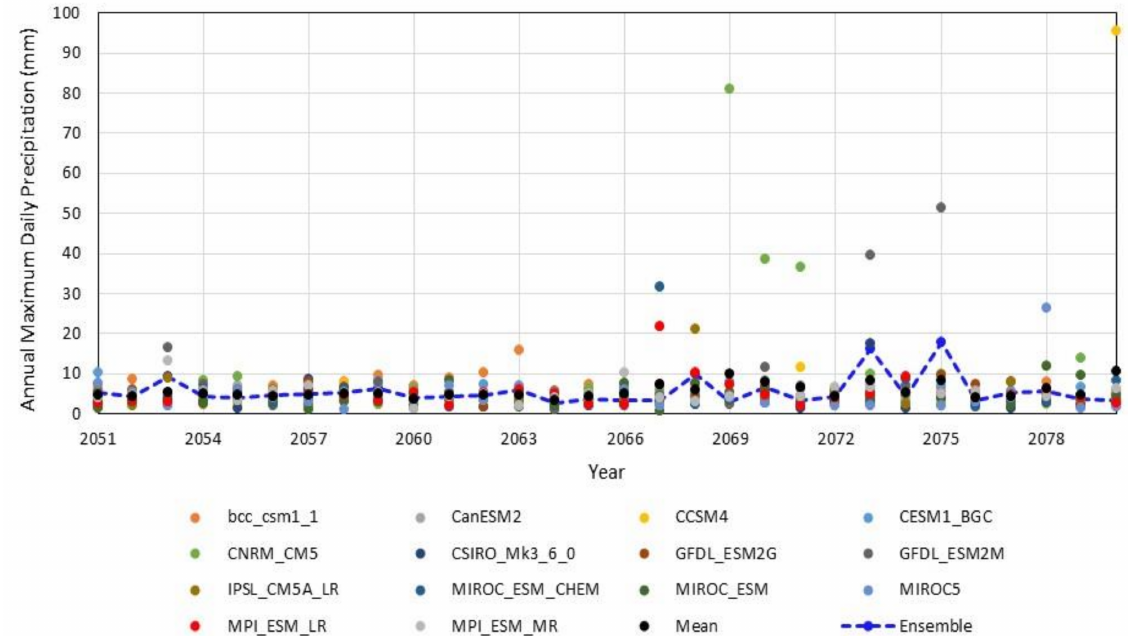
Figure 16. Annual maximum daily precipitation projected by 14 climate models under the RCP4.5 scenario for Devil’s Creek. The dashed blue line corresponds to the ensemble. Period: 2051–2080. On the other hand, the results of the model ensemble indicate a variation in the maximum annual precipitation from 2.77 mm to 17.86 mm, with an average of 5.60 mm for the 2051–2080 term under the RCP4.5 scenario. The range of uncertainty in the predictions is presented in Figure